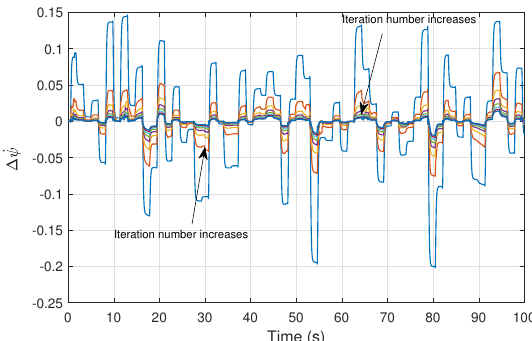
Figure 4. Example of the iteration